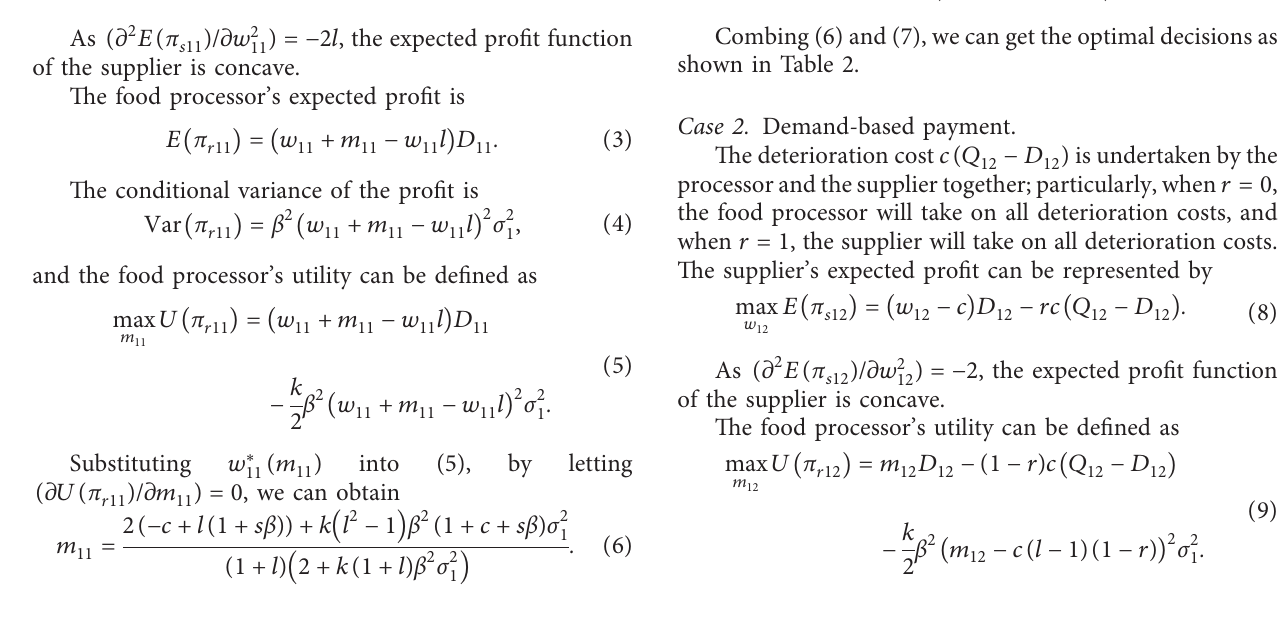
Figure 1: The decision sequence of supply chain members without safety